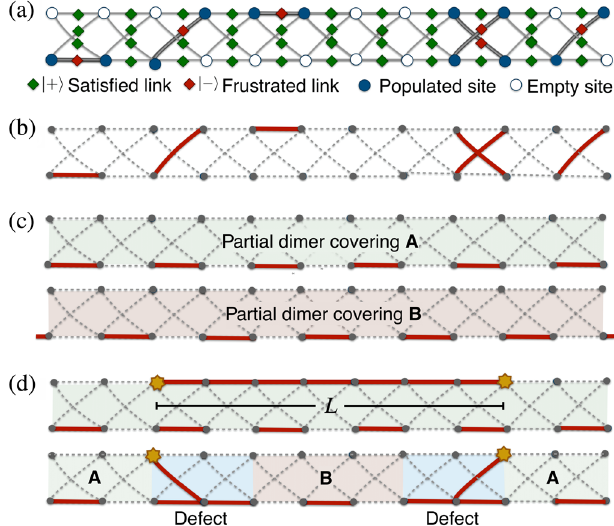
FIG. 8. Dimer coverings and soliton deconfinement. (a) In the h ≫ t , J and Δ ¼ 0 limit, Gauss law requires that some of the Ising fields are frustrated due to the distribution of fermionic matter in the ladder. (b) The frustrated Ising fields can be identified with dimers (red bonds) that partially cover the